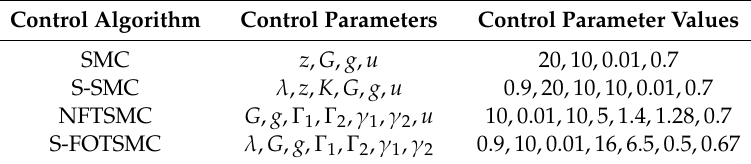
Table 2. The parameters of the control algorithms.